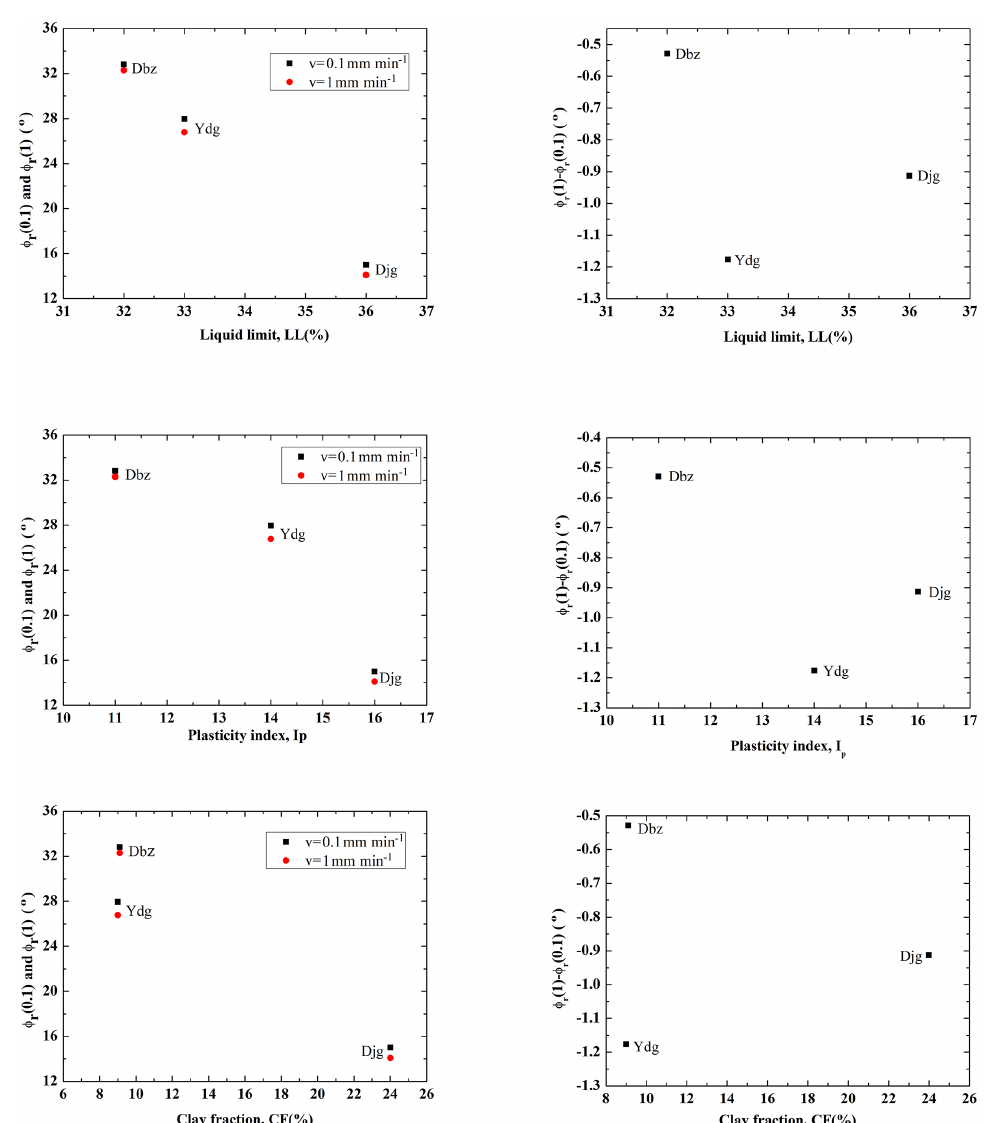
Figure 11. Relationships between residual shear parameter, the difference in residual shear parameter and the soil properties at two shear